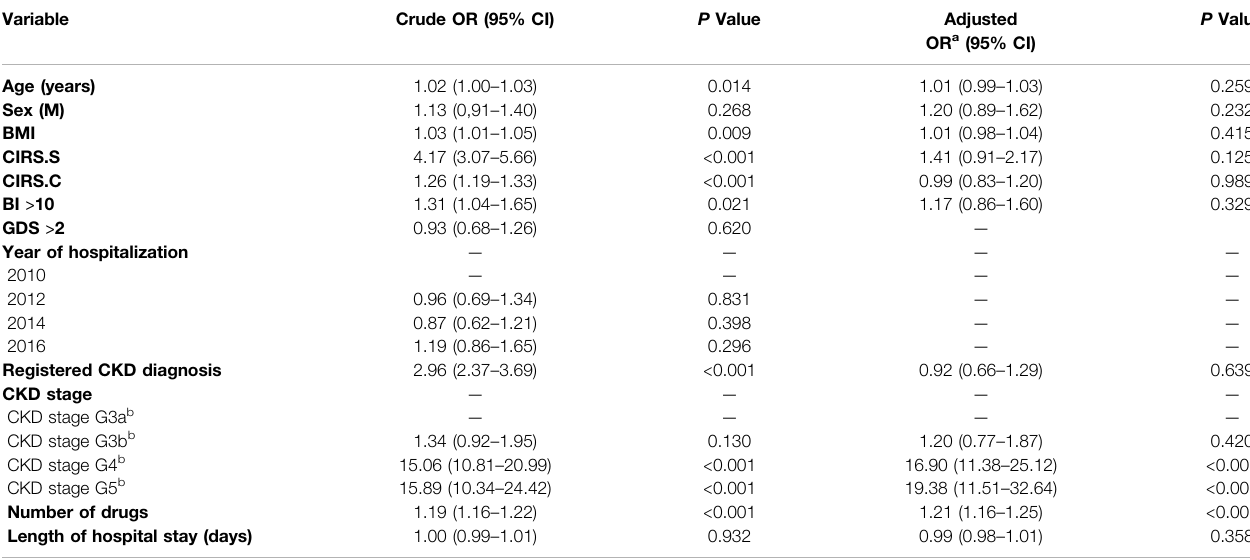
TABLE 3 | Factors associated with contraindicated drug use in patients with an eGFR < 60 ml/min/1.73 m 2 at